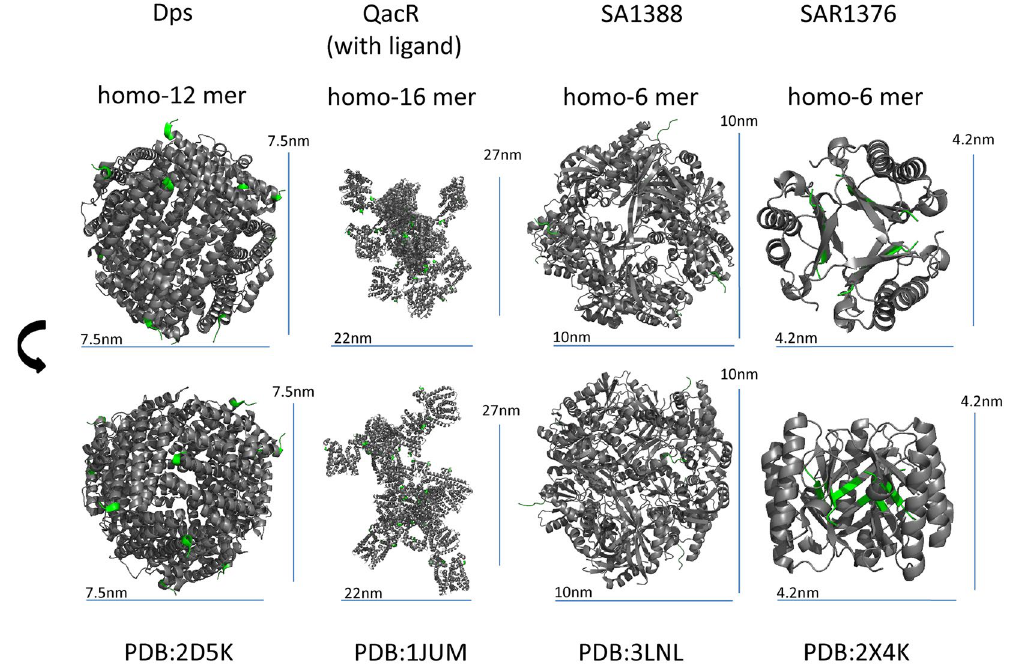
Figure 1. Crystal structures of four S . aureus multimerizing proteins, obtained from the Protein Data Bank. Gene identifiers are shown, together with two views of the molecule, rotated by 90°. The amino terminal of each protein, comprising five amino acids, is coloured